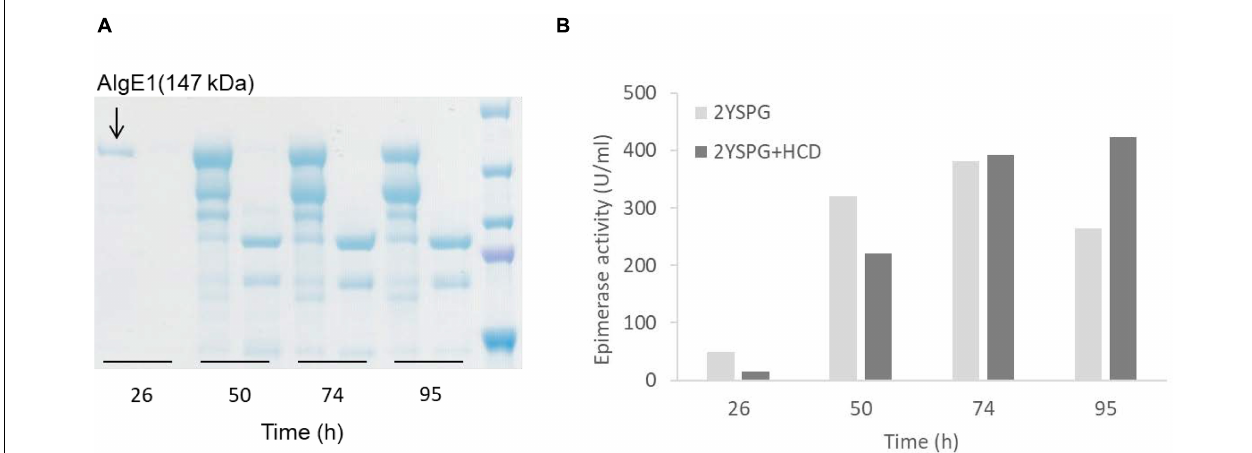
FIGURE 3 | SDS-PAGE analysis of AlgE1 stability during fermentation of RB11/algE1syn in 2xYSPG (37 ◦ C, pH 6) and 2xYSPG + 1/3HCD (37 ◦ C, pH 6) both with feeding solutions composed of glucose (30%) and methanol (10% of glucose) in samples taken at 26, 50, 74, and 95 h (A) , and AlgE1 epimerase activity (U/ml culture) of the same samples (B) . The samples on the SDS-PAGE gel are arranged in the same order as in the bar chart shown in panel B of the figure. Size of protein fragments in standard (right); 250, 150 100, 75, and 50 kDa.